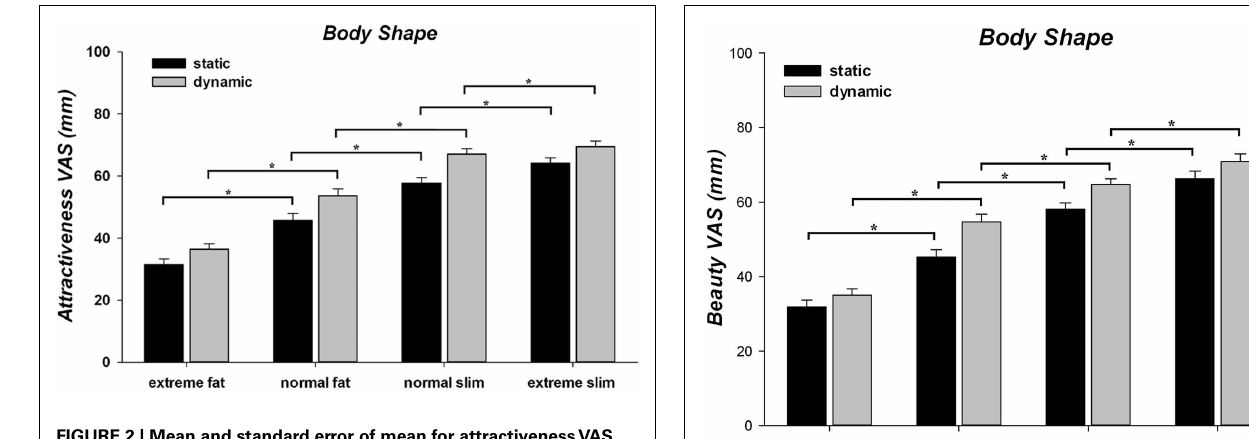
were judged as less beautiful than normal and extreme slim stim- uli and more beautiful than extreme fat stimuli (all p s < 0.001).